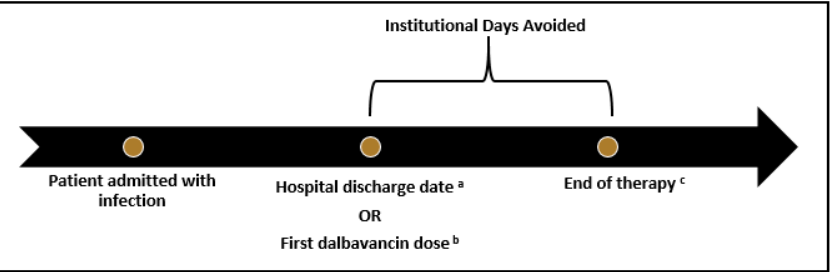
Figure 1. Hospital or SNF days saved calculation; a after first dalbavancin dose for patients who received dalbavancin inpatient; b for patients who received first dalbavancin dose as an outpatient; c